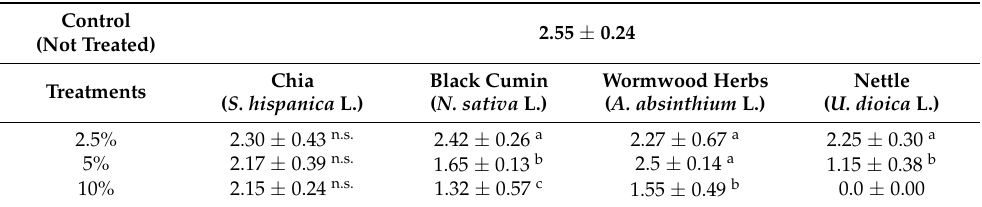
Table 11. Comparison of differences of means radicle length of pepper ( C. annuum L.) seedlings (The values in the table represent the mean value of radicle length in cm ± SD).